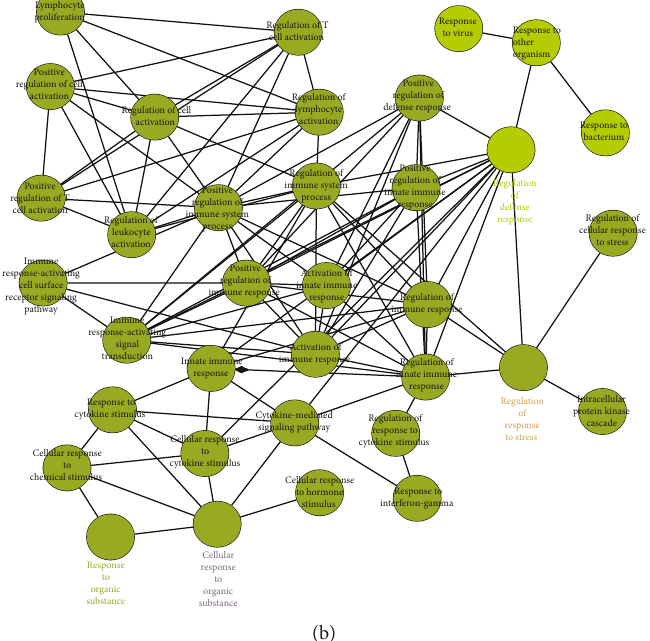
Figure 3: Functional enrichment analysis of the PPI network of MDM2, IGF1, STAT1, and RAC1. (a) 290 signi fi cant GO terms were generated by the functional enrichment analysis of the four genes, PPI network. GO terms are connected when they shared enriched genes above the threshold of kappa score. (b) The group of immunity-related terms, as indicated in the pink circle in